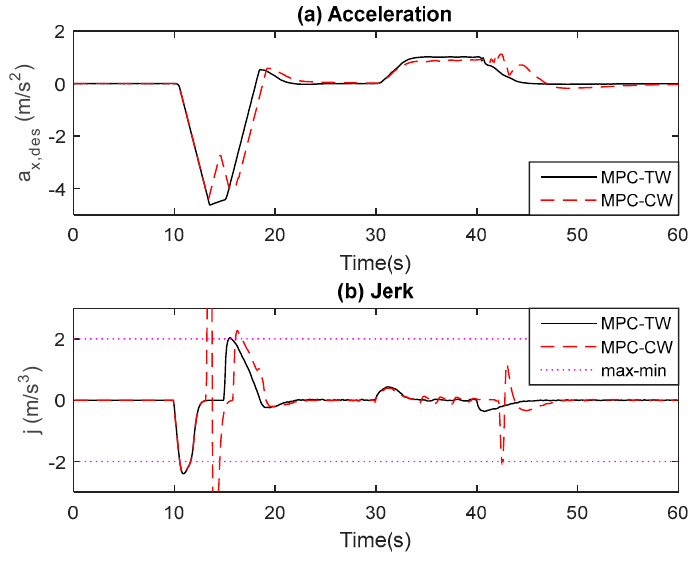
Figure 10. Acceleration and jerk.